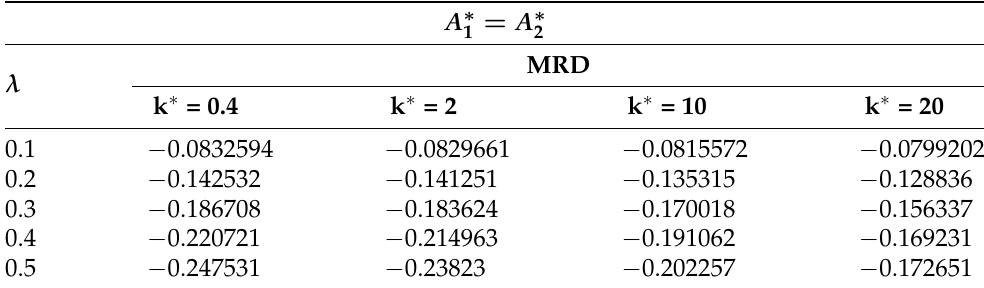
Table 4. Free beam subjected to a non-dimensional uniform load q ∗ y = − 1. Non-dimensional = A ∗ parameters A ∗ versus the non-dimensional length-scale parameter λ evaluated by the non- 2 1 dimensional Winkler parameter k ∗ ∈ { 0.4,2,10,20 } in the MRD model.